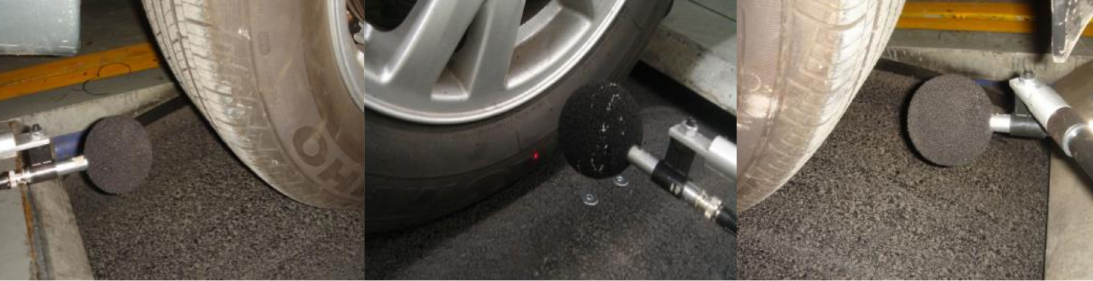
Figure 13. Arrangement of microphones around the front tires of the